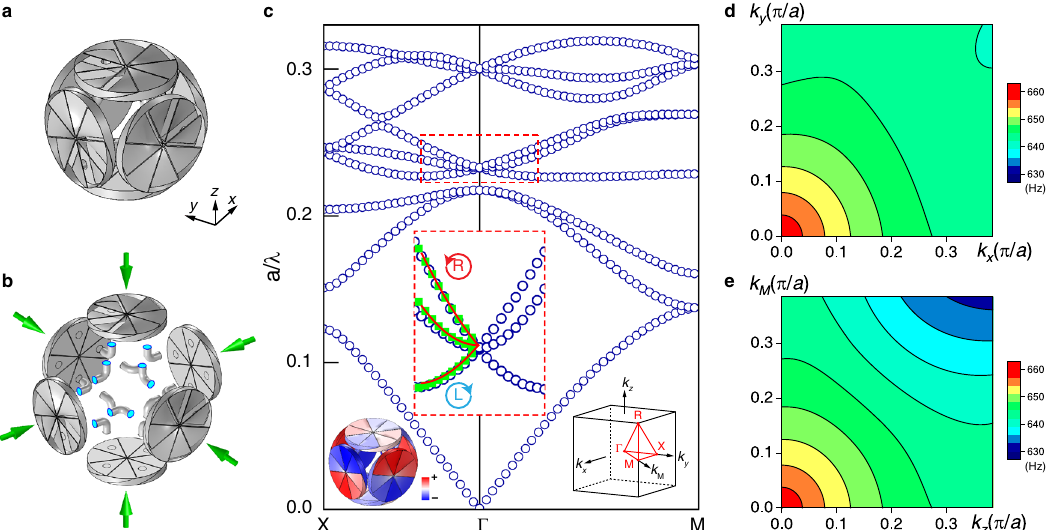
Fig. 3 The 3D acoustic micropolar metamaterials. a The unit cell consists of three orthogonally arranged resonators connected with tubes. b The details of the unit-cell components. c The band structure of the metamaterial. The middle inset (dashed red box) shows a zoom-in of the dipole bands. The blue circles denote the numerical results of the metamaterial. The green squares denote the numerical results of the micropolar effective medium. The solid red lines denote the analytical results. The inset at the left corner shows the pressure eigen fi eld of the LCP mode. The inset at the right corner shows the Brillouin zone. d The isofrequency contours of the negative band in k x – k y plane. e The isofrequency contours of the negative band in k z – k M ð S Þ ¼ (cid:2) i ϵ and dipolar resonances 43,44 or from multipole scattering 45 . . The Hamiltonian indicates a coupling between the i jki jk spin and linear crystal momentum k , which induces splitting of the eigenfrequencies 4 ω / k and leads to a “ negative band ” for ^ k j the LCP sound with spin s ¼ h LCP j S (cid:4) LCP i ¼ þ 1, as shown in Fig. 3c. Near the Γ point, the group velocity and phase velocity take opposite signs, indicating negative refraction for a sound wave passing the metamaterial-air interface. We can de fi ne an k = ω (cid:2) with v being the speed effective refractive index n ¼ (cid:2) v 0 0 T of sound in air 28 . This acoustic activity-induced negative index is different from those derived from overlapped monopolar